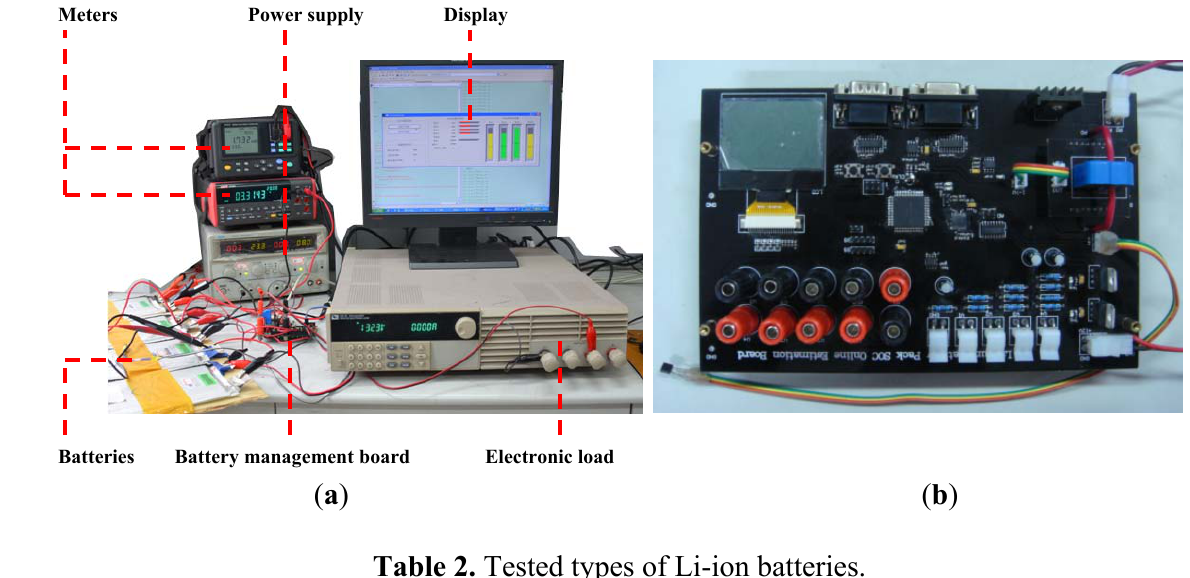
Figure 7. Experimental battery SOC estimation system. ( a ) System setup; ( b ) Developed battery management board.